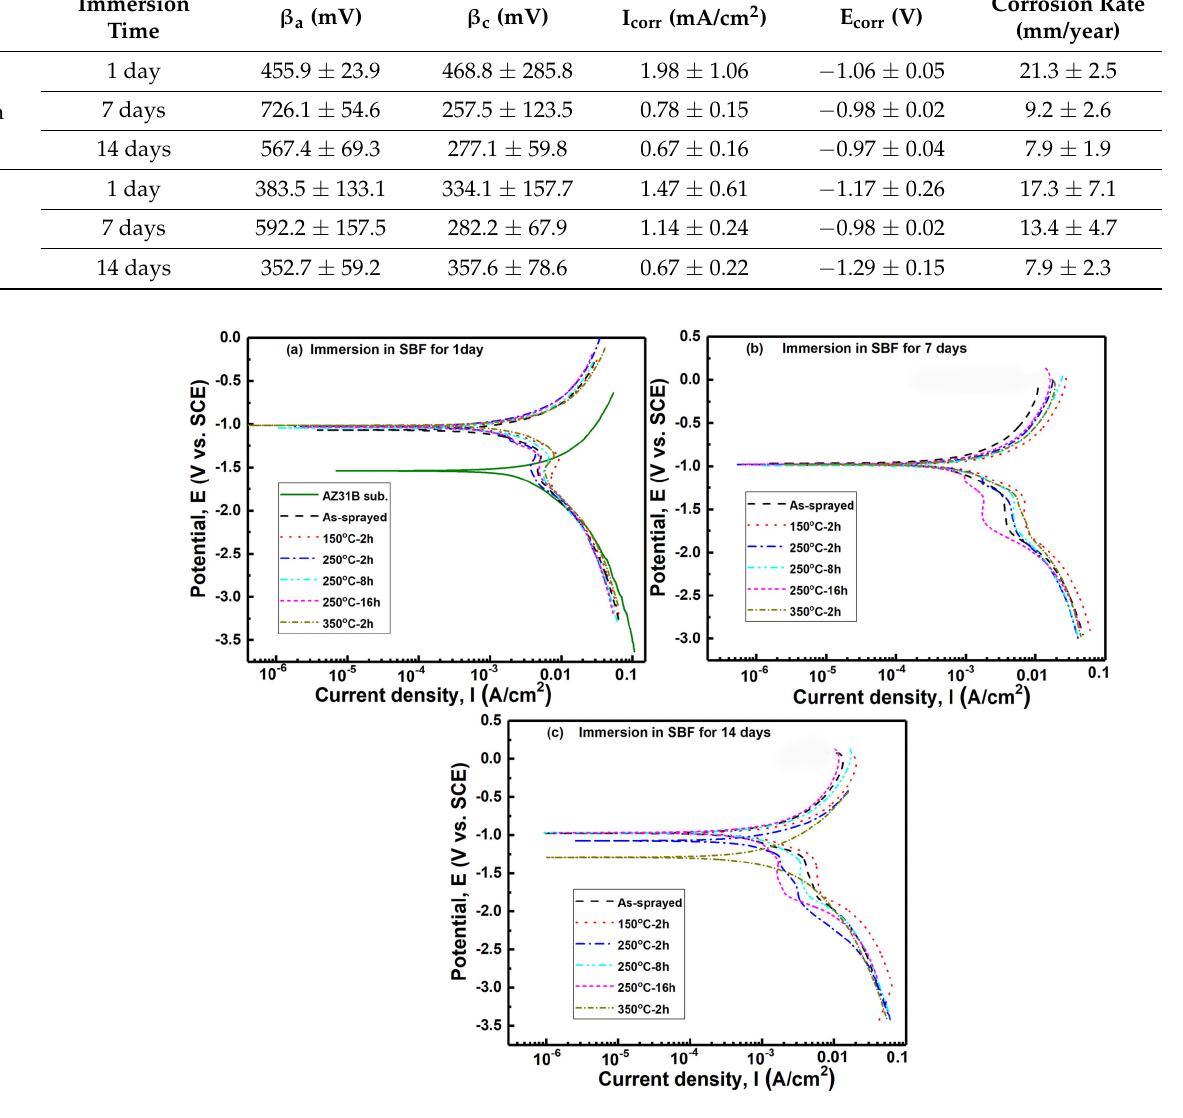
Figure 8. Polarization curves of Zn coatings after different immersion time. Table 1. Fitting results from polarization curves in Figure 8.